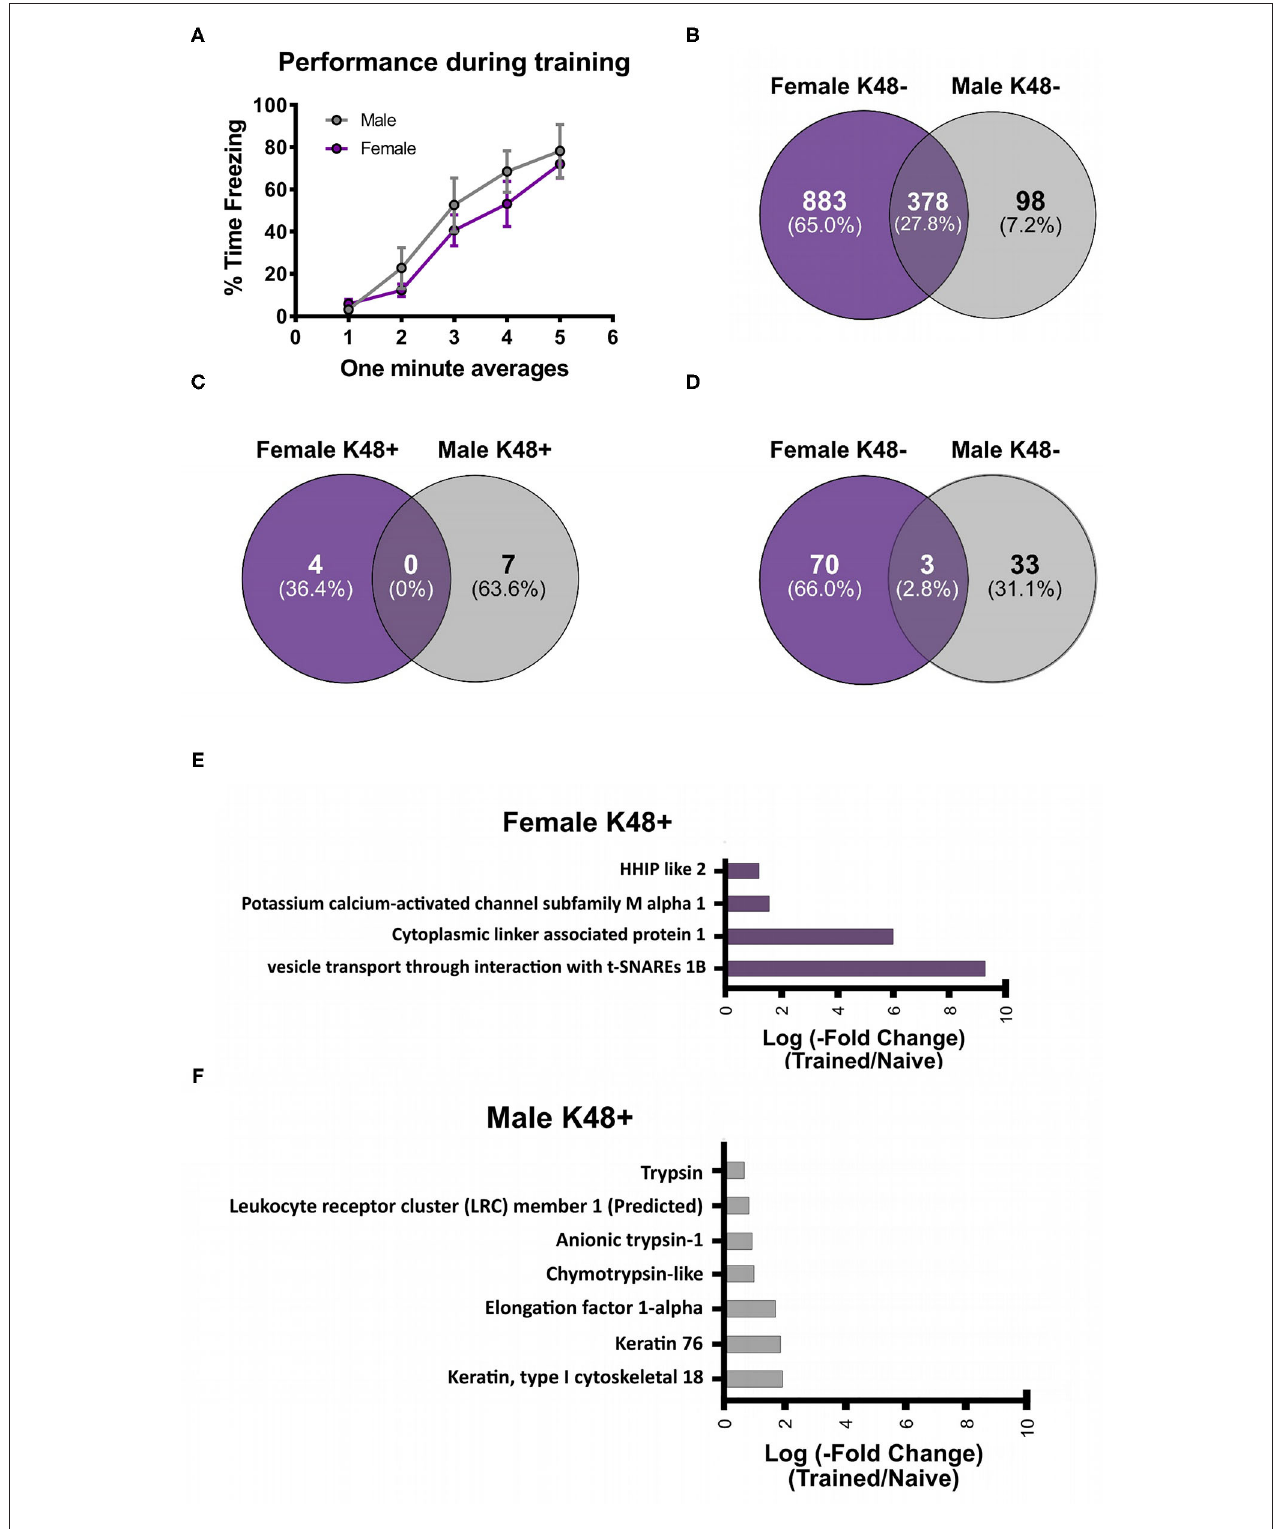
FIGURE 1 | Sex-specific changes in K48 polyubiquitin protein targets in the amygdala of male and female rats during fear memory formation. Male and female Sprague-Dawley rats were trained to a foreground contextual fear conditioning task ( n = 5 per sex) and the basolateral amygdala (BLA) was collected 1h